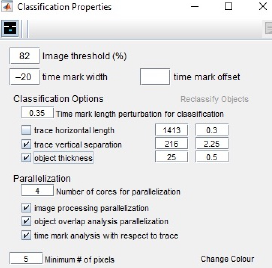
Figure 9. Threshold parameters for seismogram classification in